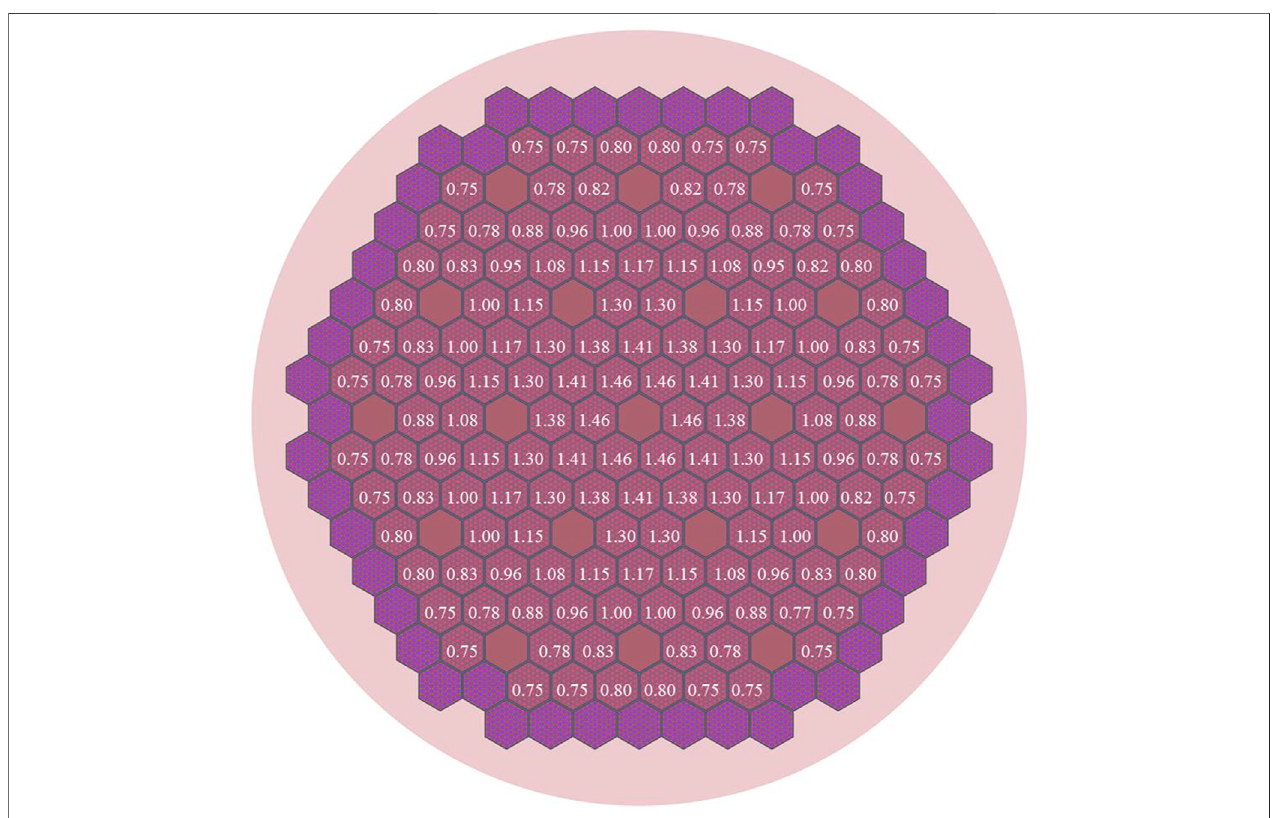
FIGURE 5 | Radial assembly power result of the SLBR-50.